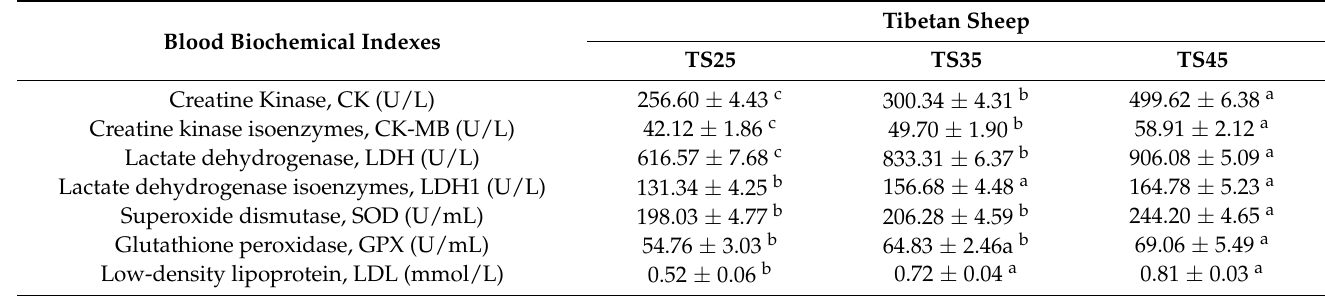
Table 3. Blood biochemical indexes of Tibetan sheep at different